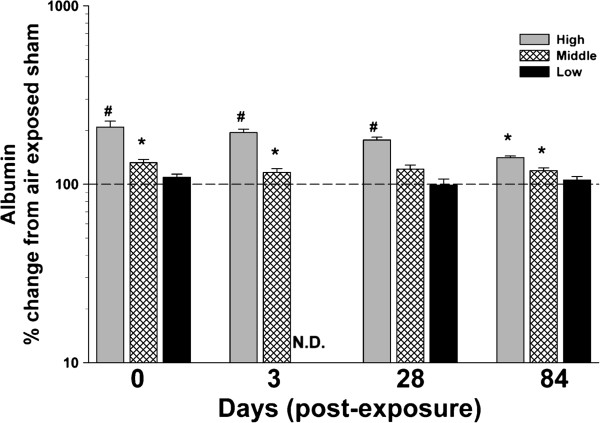
Effect of multi-walled carbon nanotube (MWCNT) inhalation on pulmonary permeability at different time points after exposure. Albumin (mg/dL), an indication of a loss of epithelial barrier integrity, was measured from the first fraction of collected bronchoalveolar lavage fluid. Data are expressed as percent (%) change from respective sham (dashed line – 100%). N.D. – not determined. *p<0.05 vs. respective sham; #p<0.05 vs. other MWCNT depositions for a given time point only.